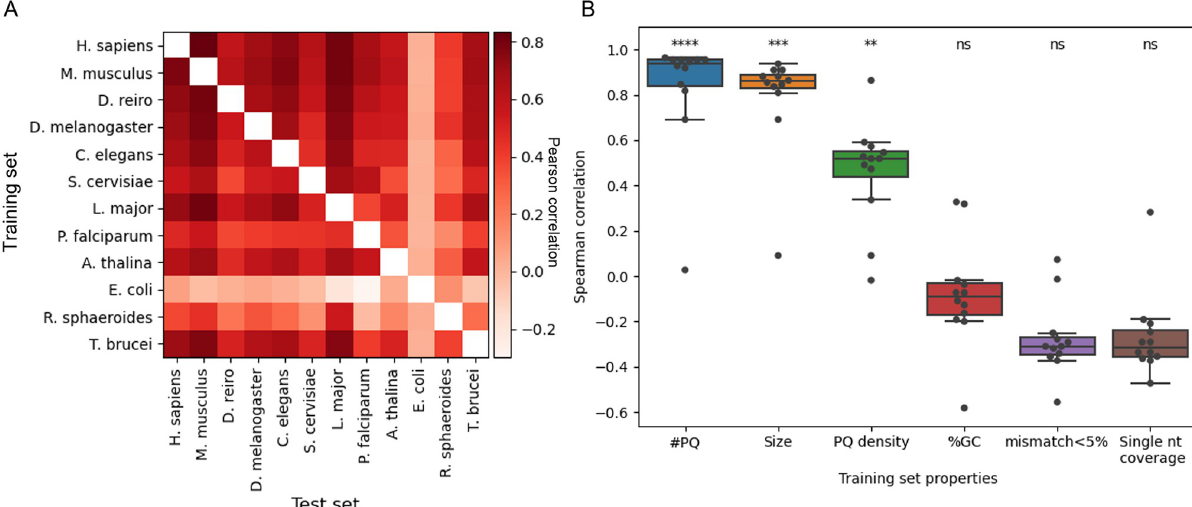
Fig 6. Inter-species G4mismatch analysis and correlation to genomic and experimental properties. (A) Inter-species G4mismatch K + prediction performance. Each model was trained on data of one species, and tested on all other species. Prediction performance is reported in Pearson correlation of predicted and measured G4 mismatch scores. (B) Correlations between G4mismatch models and number of PQs (#PQs), genome size, PQ density, GC-content (%GC), frequency of mismatch scores under 5% (mismatch < 5%), and single-nucleotide coverage of the training datasets. For each property, prediction results were Spearman-correlated to model performance in Pearson correlation. P-value notation: ns = non-significant, ** � 0.009, *** � 0.001, **** � 0.0001, adjusted for harmonic mean p-value.